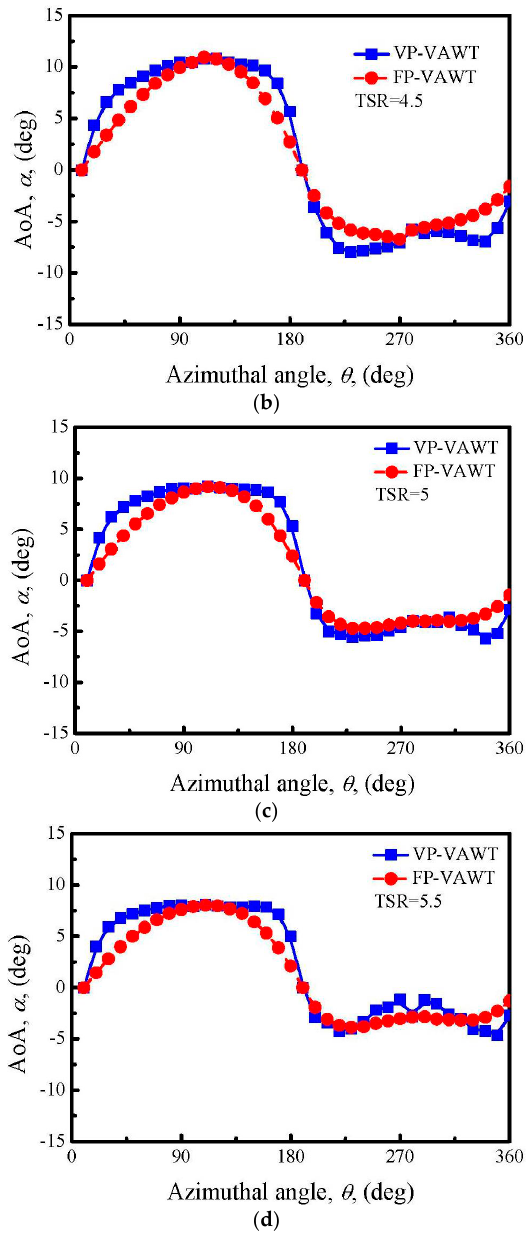
Figure 9. Angle of attack (AoA) as a function of azimuthal angle in variable pitch (VP) and fixed pitch (FP) VAWTs. ( a ) TSR = 4; ( b ) TSR = 4.5; ( c ) TSR = 5; ( d ) TSR = 5.5. (FP) VAWTs. ( a ) TSR = 4; ( b ) TSR = 4.5; ( c ) TSR = 5; ( d ) TSR =